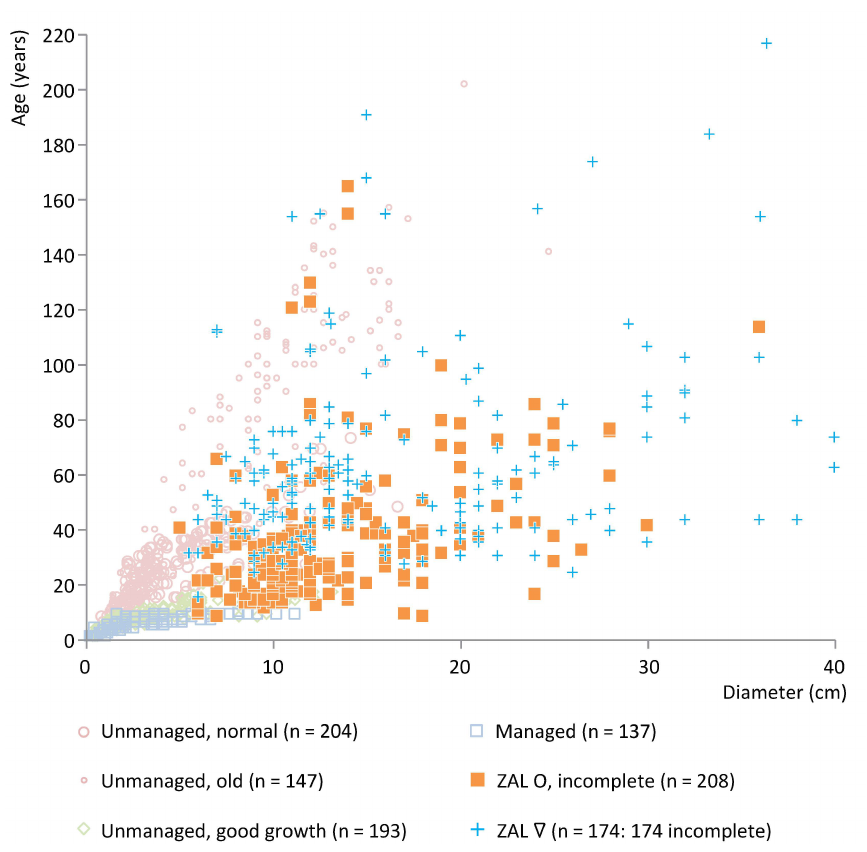
Figure 9. Posts of ash from Založnica, cluster KK, plotted against a representative selection of modern ash reference data. O = roundwood, ∇ = split wood.